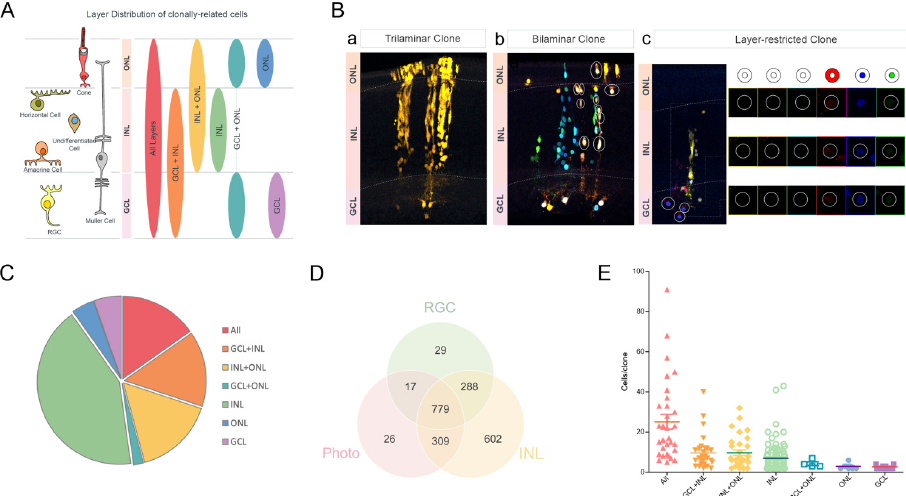
Figure 3. Retinal layer distribution and the clonal size of cell-derived progeny after targeting CM progenitors. ( A ) General overview of layer distribution of clonally related cells. Retinal cell types are represented on the left side, whereas the seven group classifications depending on the clone layer distribution are represented on the right side. ( B ) Merge the confocal images of a trilaminar clone (a) with cells located at different retinal layers (ONL, INL and GCL), a bilaminar clone (b) formed by a photoreceptor, three horizontal cells and six undefined cells and a layer-restricted clone (c) formed by three RGCs. Circles represent cells belonging to the same clone. Detailed expression of XPF defining the color code of sibling cells as well as the schematic representations are shown in (c). ( C ) Pie chart displaying the proportions of the different layer distribution of sibling cells. ( D ) Venn diagram representing the number of cells belonging to clones formed by different combinations of cell types, such as RGCs, photoreceptors and INL cells. ( E ) Size of the clones distributed along the different retinal layers. Clones containing cells at all three layers were the larger ones. GCL: ganglion cell layer; INL: inner nuclear layer; ONL: outer nuclear layer; RGC: Retinal ganglion cell; Photo: Photoreceptor